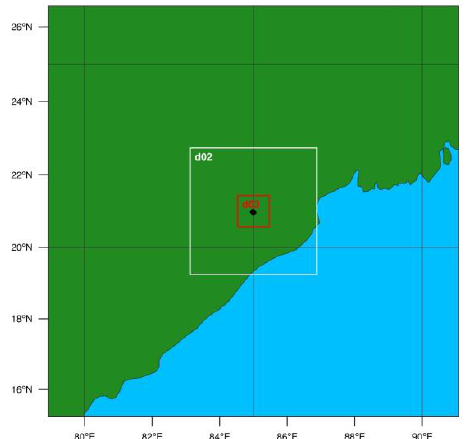
Figure 1. Configuration of nested model domains with Angul as the inner domain